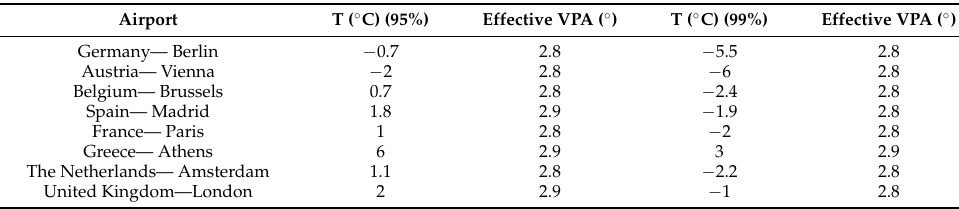
Table 7. Effective VPAs for temperature